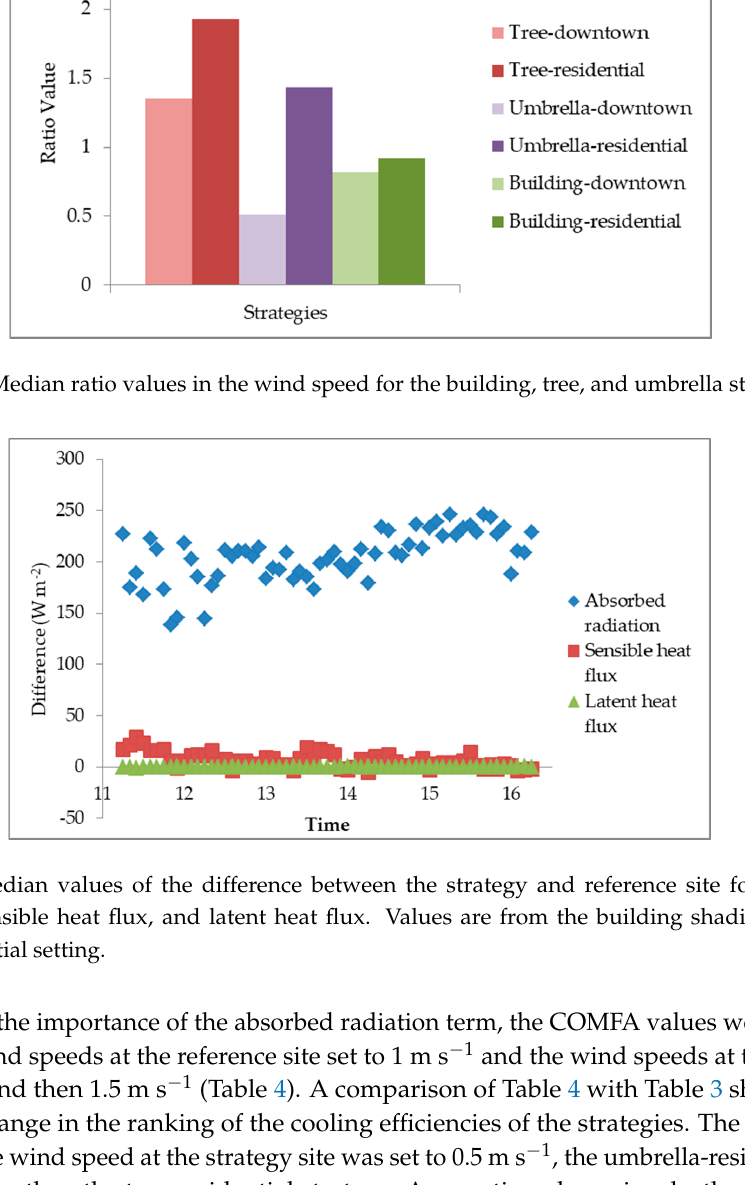
10 of 17 Figure 6. Median ratio values of the various components of the energy budget caused by a strategy. For the identification of the columns, “d” is the downtown setting, “r” is the residential setting, “b” is the building shade strategy, “t” is the tree shade strategy, and “u” is the umbrella shade strategy. 3.2. Impact on the Latent and Sensible Heat Flux As can be seen in Figure 6, use of any of the shading strategies in either setting caused very little change in the latent heat flux (all ratios were close to a value of 1). The main driver for the latent heat flux is the difference between the vapor pressure of the skin surface and the vapor pressure of the air. None of the strategies used had a direct impact on the atmospheric vapor pressure. Use of a strategy